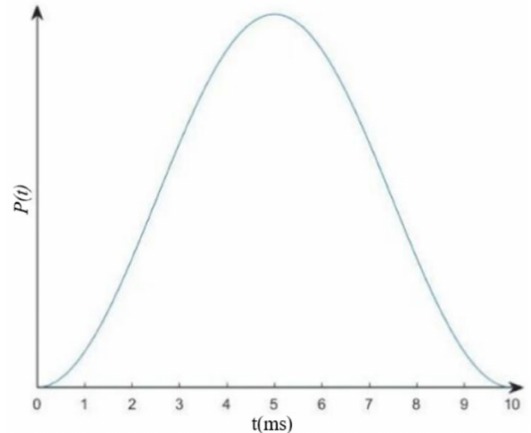
Figure 1. Stress wave curve with time.